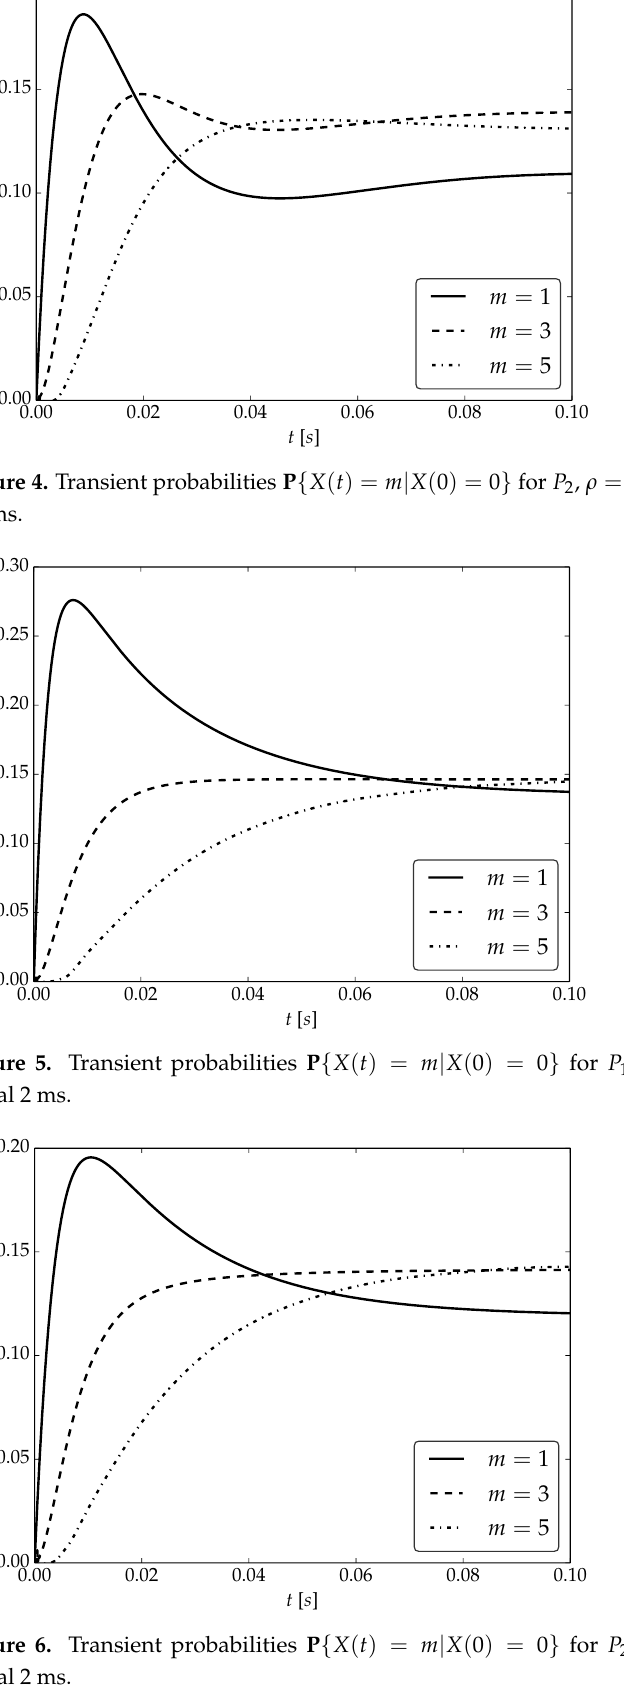
Figure 6. Transient probabilities P equal 2